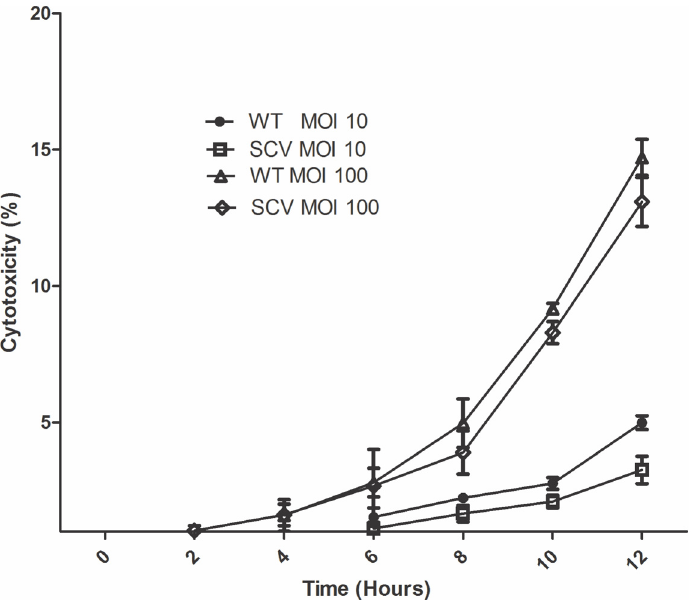
Fig 3. Percentage of cytotoxicity to A549 epithelial cells. Cells were infected with the bacteria at a MOI 1:10 and 1:100 for 0, 2, 4, 6, 8, 10, and 12 hours. The values are the means ± the standard deviation of each of three independent experiments, each performed in